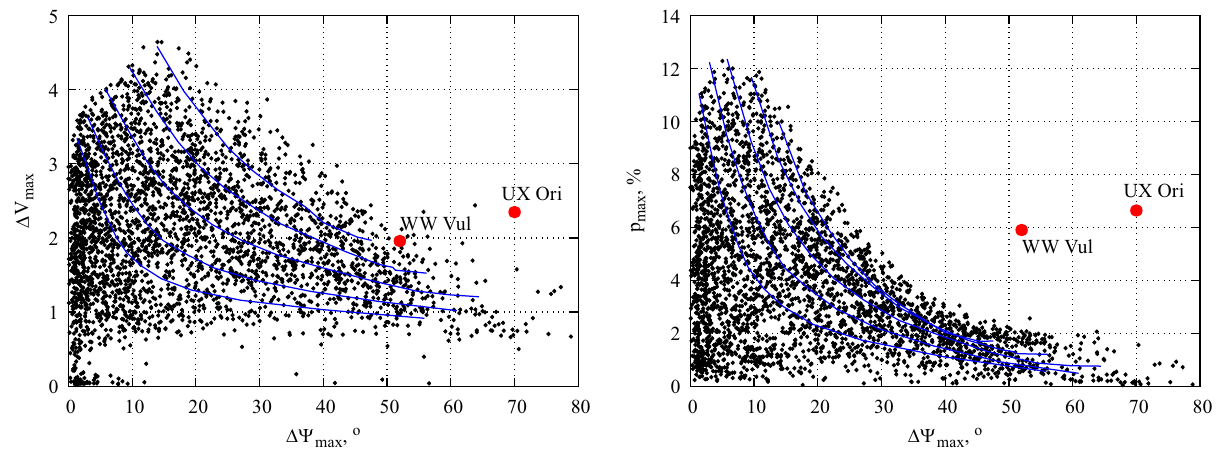
Figure 9: The comparison of the model results ( black ) with UX Ori and WW Vul observations ( red ) . The left panel shows ratios of maximum fading level and the maximum change in the positional angle after passing through it. The right panel demonstrates ratios of the polarization in the brightness minimum and the maximum change in the positional angle. For several perturbation models with a constant shape, the simulation results with a variable mass out fl ow rate are shown by blue